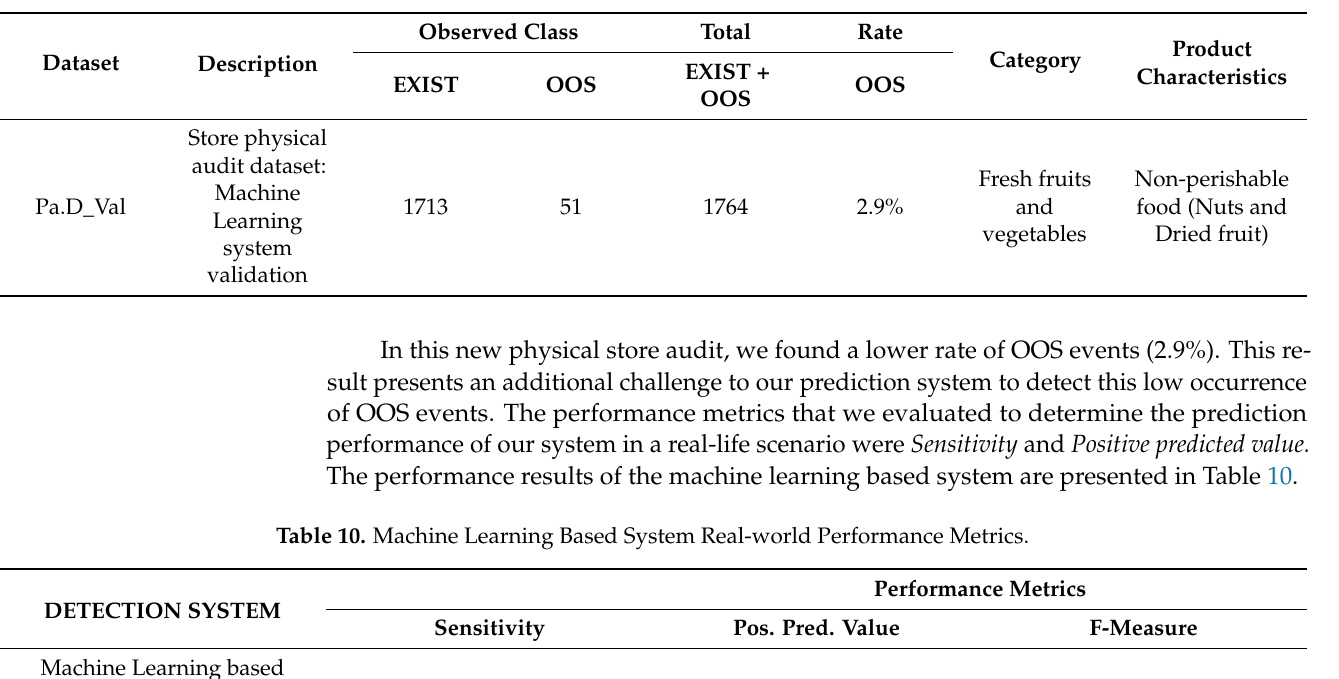
Table 9. Physical store audit: Machine Learning Based System real-world validation.